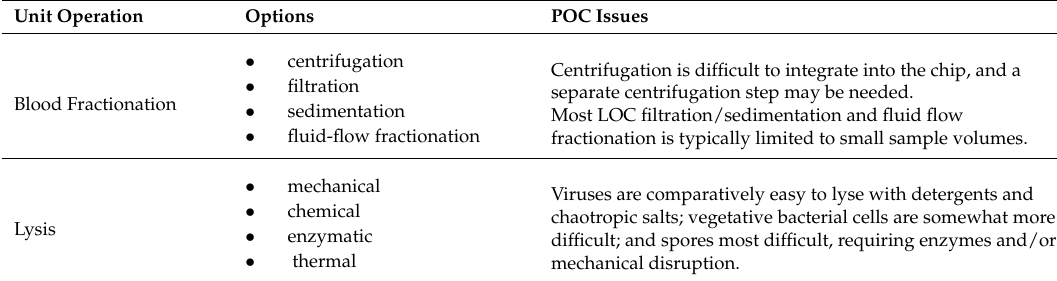
Figure 1. Processing steps (‘unit operations’) of Nucleic Acid Amplification Tests (NAATs) molecular diagnostics. Plasma from whole blood samples, or raw oral fluid or urine, is lysed to release nucleic acids (DNA or RNA) from virus or cellular pathogens. The soluble nucleic acid is isolated in a purified, concentrated form. Pathogen-specific nucleic acid is enzymatically amplified using PCR (polymerase chain reaction) or isothermal amplification methods. The amplification products (a positive test result) are detected either after amplification (end-point detection) by color dyes sensitive to DNA, or in real-time (during amplification) by, e.g., fluorescence due to intercalating dyes, or bioluminescent reporters coupled to the amplification reaction. Reagents (enzymes, primers, reporters) and buffers are required at the steps indicated. Table 2. Design options for microfluidic implementation of nucleic acid amplification test unit operations.